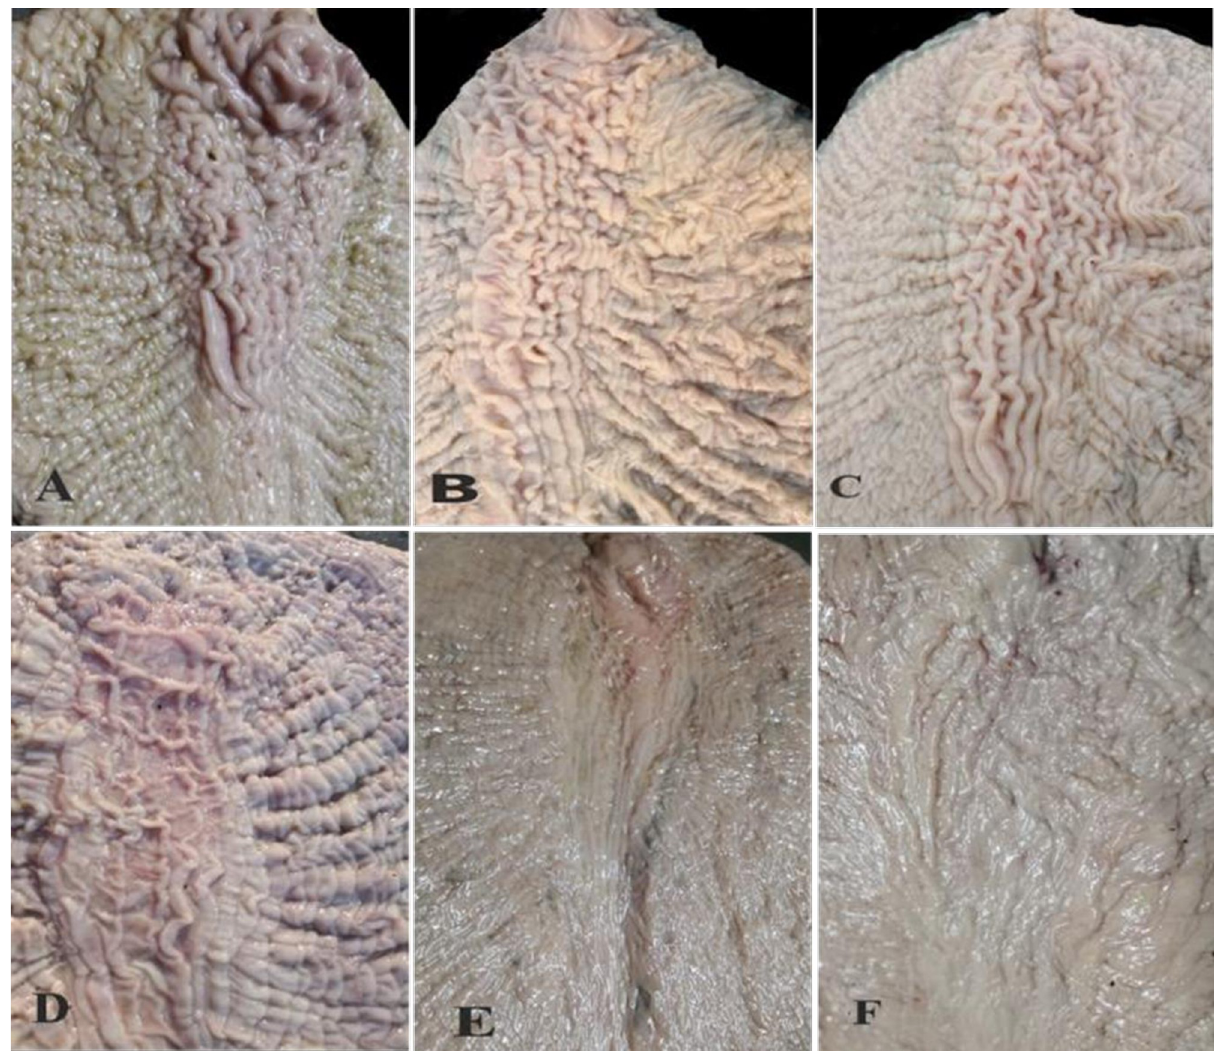
Fig 4. Mucosal view of ALNA in Dromedary camel in different ages. The mucosal folds were more and well-formed in young (A) and pubertal camels (B). Mucosal fold’s number, height, and width decreased with age increment. A: 6months old; B: 4 years; C: 7years old; D: 15years old; E: 17year old & F: 20 years